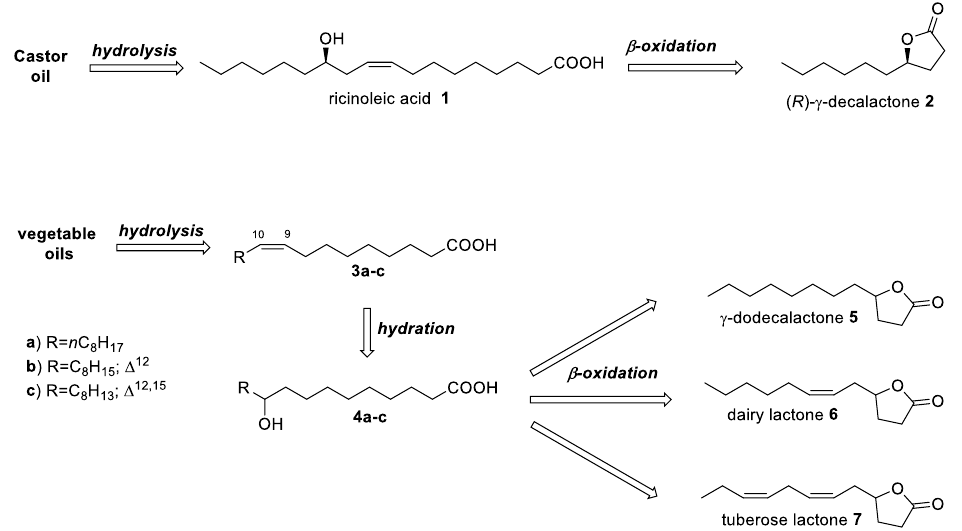
Figure 1. Synthesis of natural (+)-( R )-gamma-decalactone from castor oil and the prospective synthesis of natural C 12 lactones gamma-dodecalactone, dairy lactone and tuberose lactone from vegetable oils through exploitation of UFA hydration reactions.